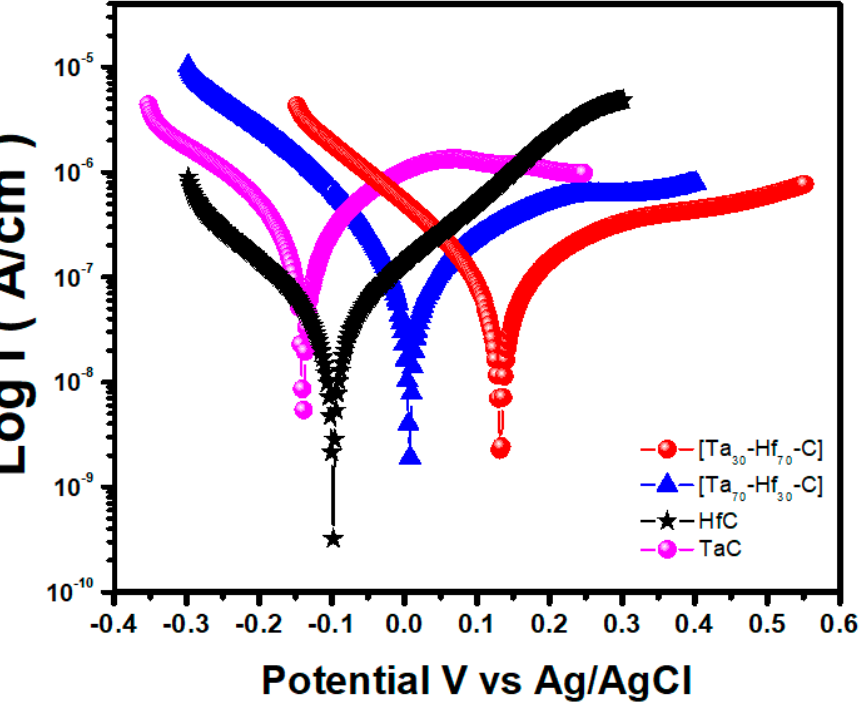
Figure 16. Tafel polarization curves for TaC and HfC individual coatings and (Ta 70 -Hf 30 -C) and (Ta 30 -Hf 70 -C) composite coatings.